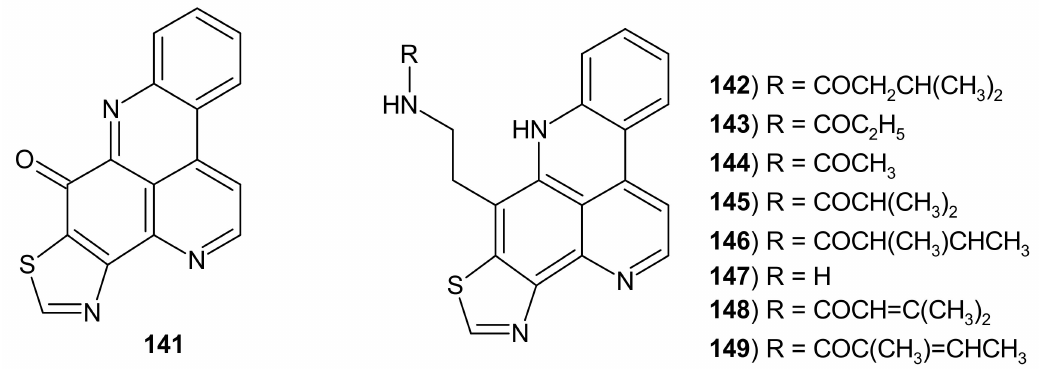
Figure 38. Kuanoniamines 141–149.